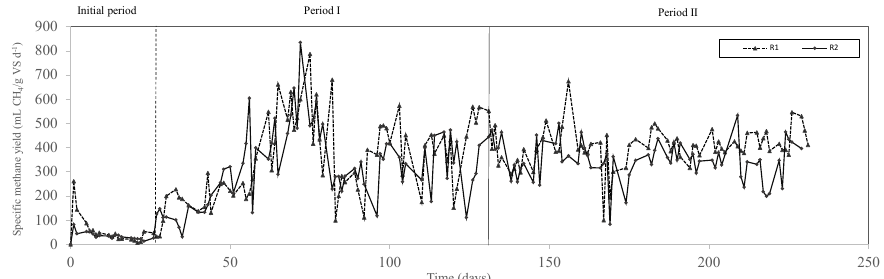
Figure 4. Methane yields during semi-continuous operation of R1 and R2.